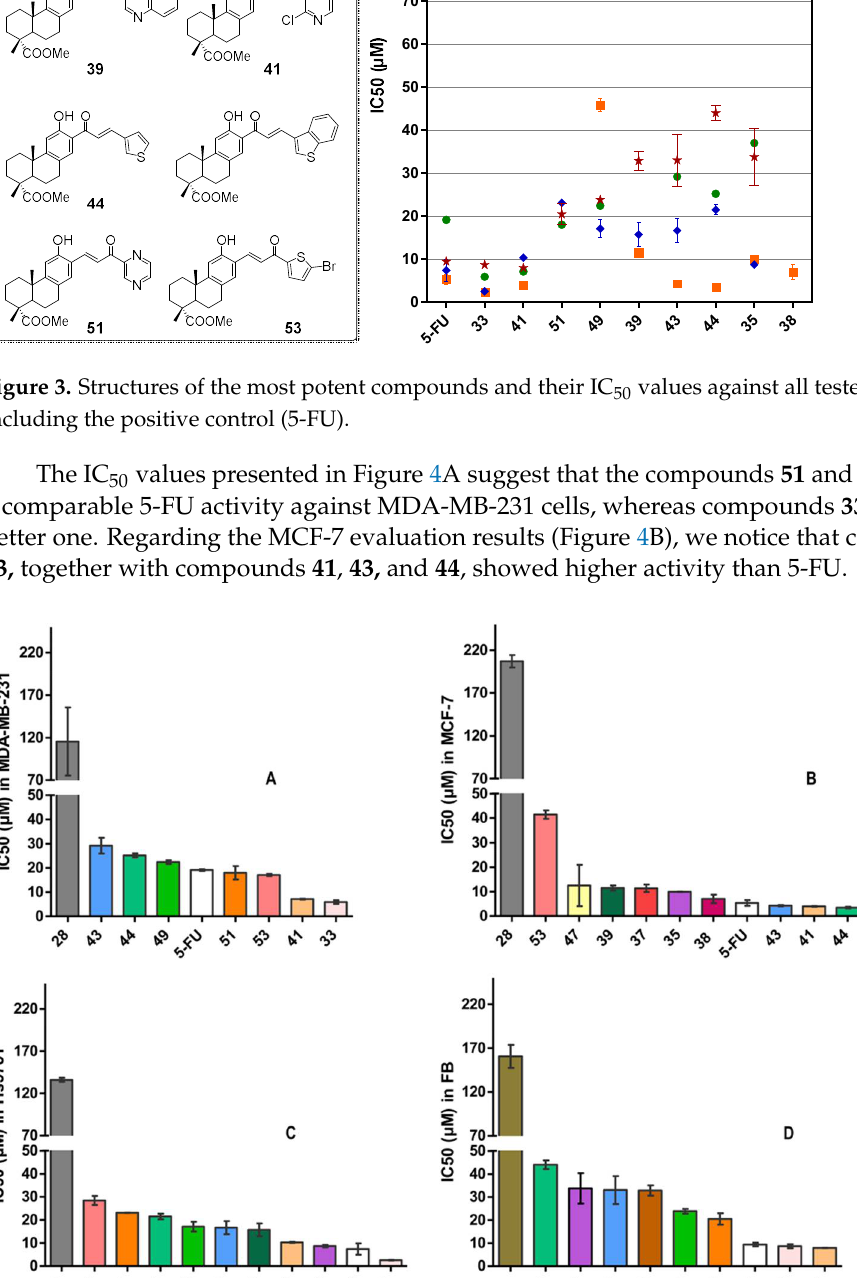
μM) combines a comparable to 5-FU (IC 50 = 5.37 μM) activity for MCF-7 with a very low toxicity (IC 50 = 160.65 μΜ, SI = 22.75), being 12.9 times less toxic than 5-FU against normal fibroblasts. 2.3. Structure-Activity Relationships Structurally, the hybrid chalcones can be classified in two series, Series A, where the DHA’s aromatic ring coincides with the chalcone “A” ring (compounds 31 – 47 ), and Series B, where the DHA’s aromatic ring coincides with chalcone “B” ring (compounds 48 – 53 ). Regarding the structural elements of the Series A hybrids, which affect their activity, we notice the following: The introduction of a heteroatom into the aromatic system of ring B remarkably im- proved their cytotoxicity. More specifically, the pyrrole ( 43 ) and thiophene ( 44 ) deriva- tives are highly cytotoxic against the MCF-7 cancer cell line. However, a fused heterocyclic form for ring B, such as an indole ( 46 ) or benzothiophene ( 47 ), as well as the presence of a bromo substituent on the thiophene heterocycle of 45 , led to less active compounds or to complete loss of activity. Among pyridyl type derivatives 32 – 35 , the 3-pyridyl derivative 33 showed to be the most active compound against all the cancer cell lines (IC 50 = 2.21–5.89 μM) and had sim- ilar cytotoxicity with 5-FU (Figure 3, Table 1). On the other hand, the quinoline derivatives 38 – 41 showed moderate activity, except hybrid 41 , which was active against all cancer cell lines, with IC 50 = 7.12 μΜ (ΜDA-MB- 231), 3.99 μΜ (MCF-7), and 10.31 μΜ (Hs578T), however it showed high toxicity against normal fibroblasts (IC 50 = 7.96 μΜ).